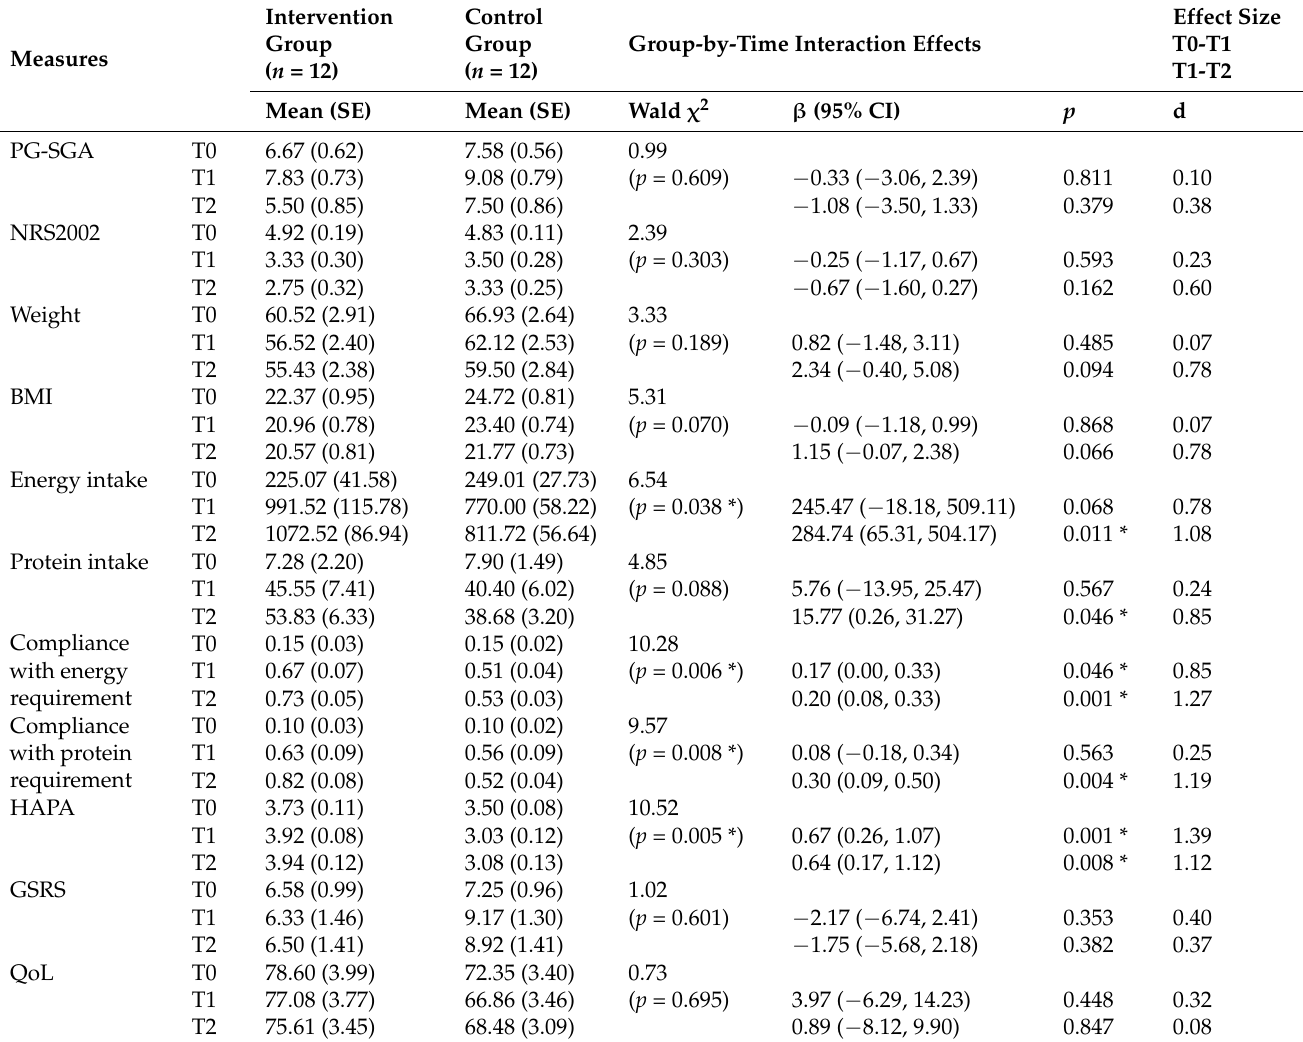
Table 4. Generalized Estimating Equations (GEE); results of the comparison of secondary outcomes between the intervention and control groups in the intention-to-treat (ITT)